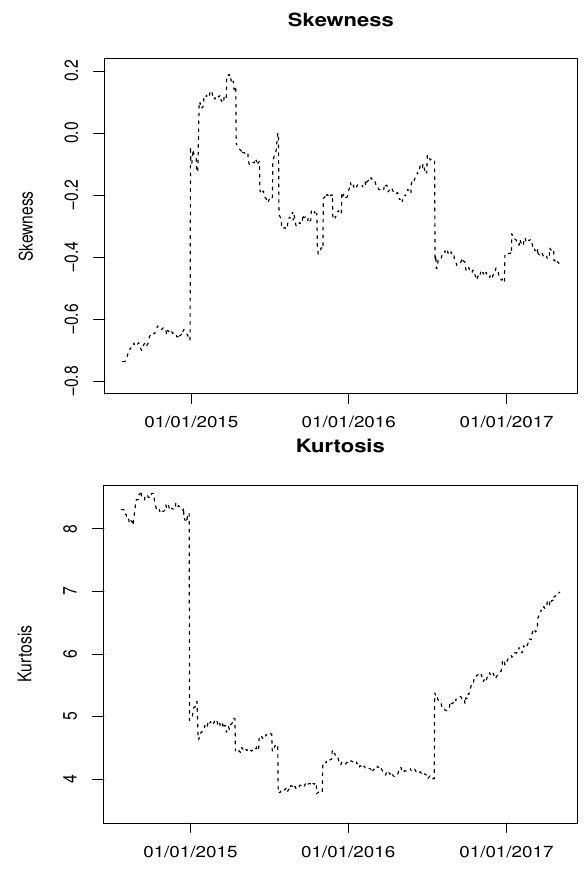
Figure 2. Time varying skewness and kurtosis plots of ISE-100 index. Table 2. In-sample performance of GARCH models under skewed and fat-tailed innovation distributions.